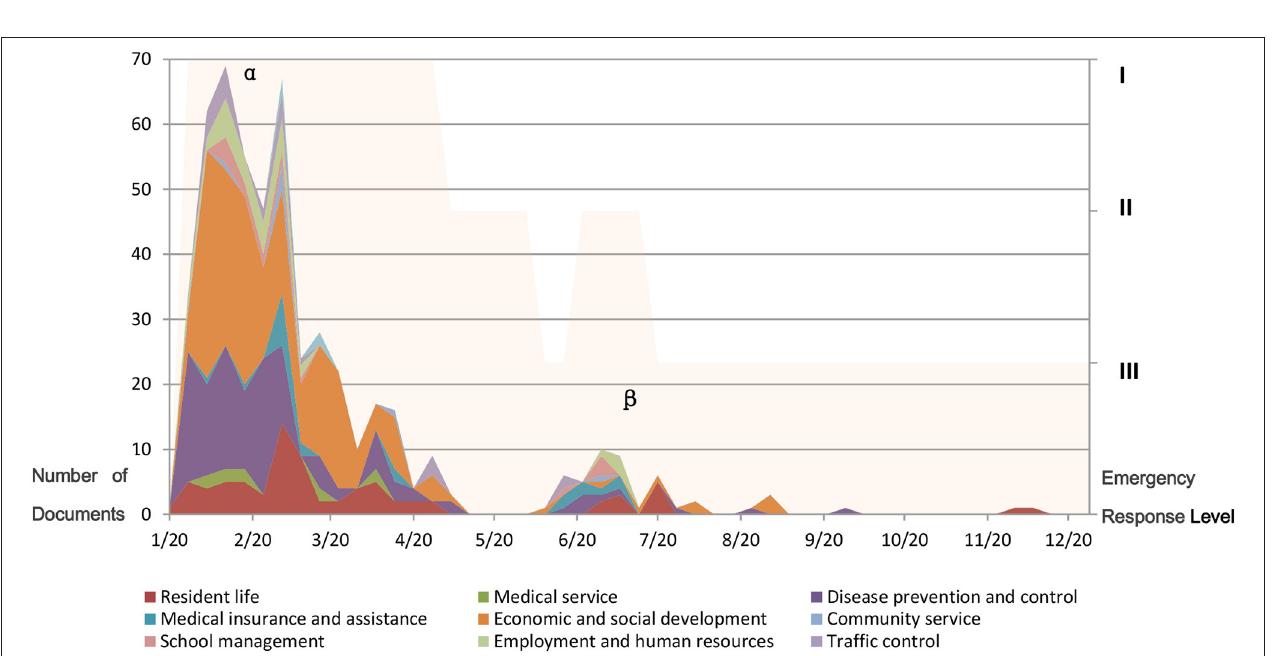
FIGURE 2 | Classification of Daily content of policy documents on the official website of the Beijing Municipal Government from January 20 to December 31, 2020. Peak α was the peak of policy documents publishing during the stage of the Level I emergency response; Peak β was the peak of policy documents publishing during the stage of the second Level II emergency